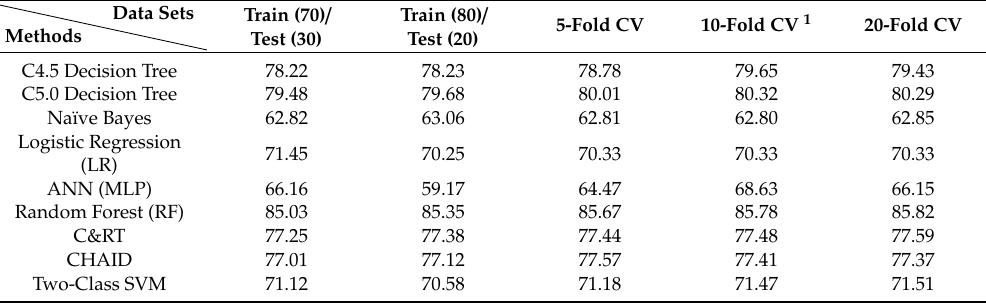
Table 2. Prediction accuracy of stroke by machine learning algorithm with all 28 attributes